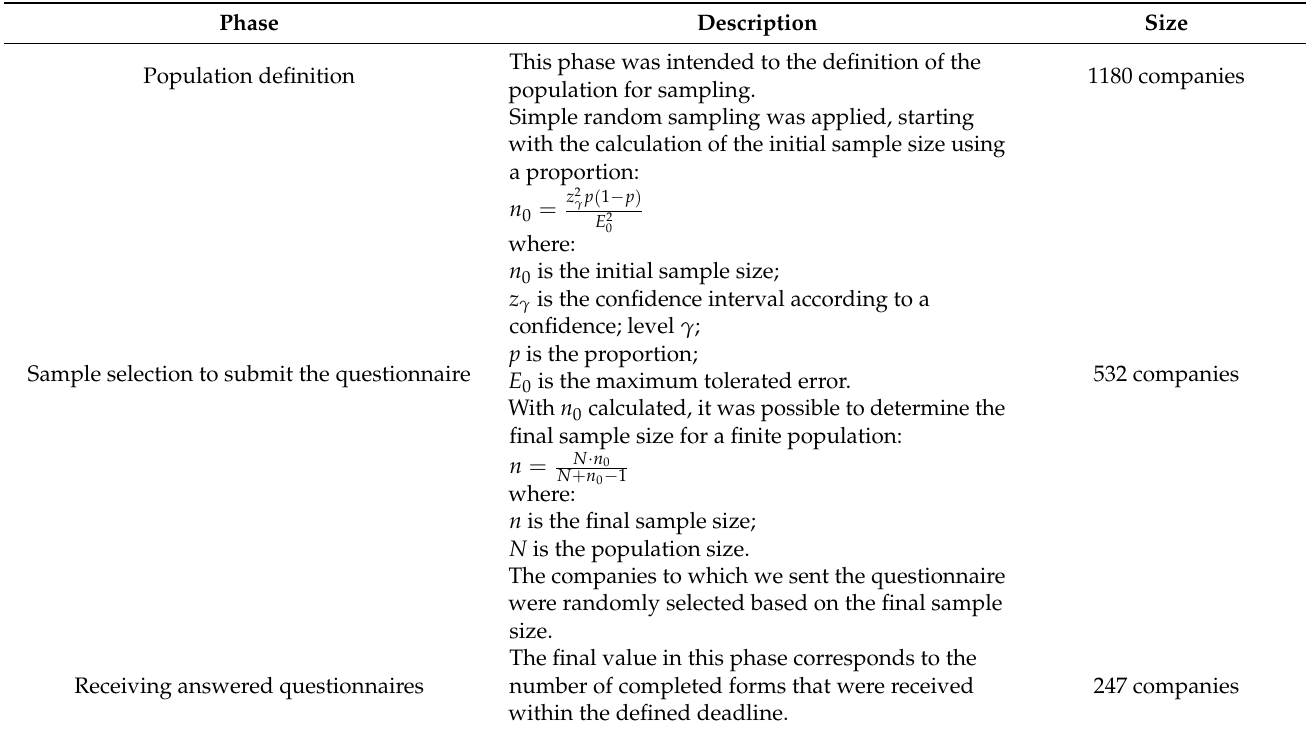
Table 1. Sampling process adopted in the study.